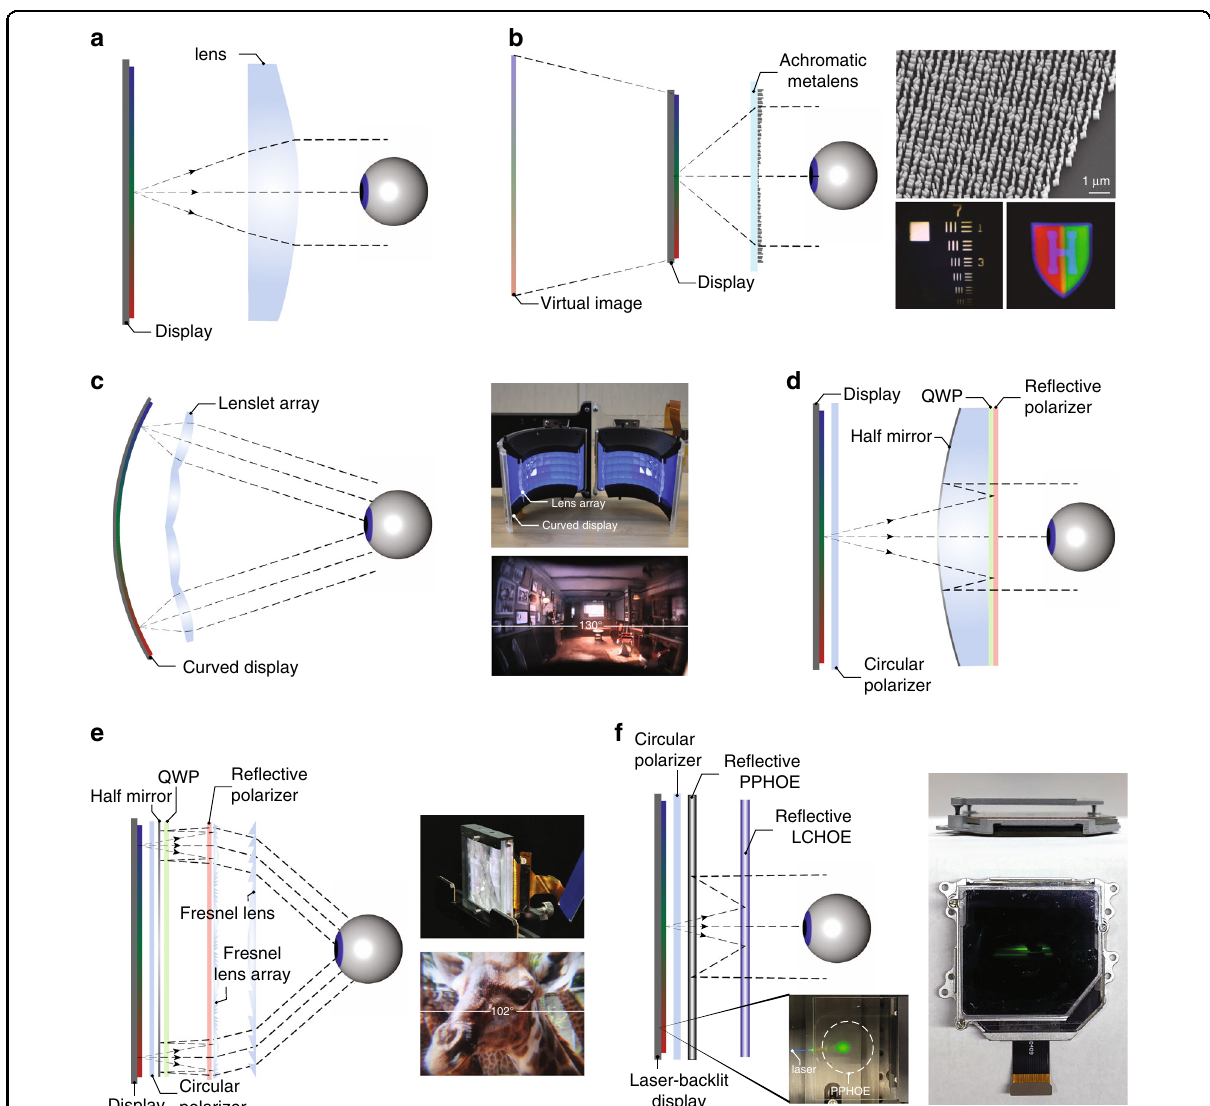
Fig. 5 Schemes to reduce the form factor of a VR display. a Schematic of a basic VR optical con fi guration. b Achromatic metalens used as VR eyepiece. c VR based on curved display and lenslet array. d Basic working principle of a VR display based on pancake optics. e VR with pancake optics and Fresnel lens array. f VR with pancake optics based on purely HOEs. Reprinted from b ref. 87 under the Creative Commons Attribution 4.0 License. Adapted from c ref. 88 with permission from IEEE, e ref. 91 and f ref. 92 under the Creative Commons Attribution 4.0